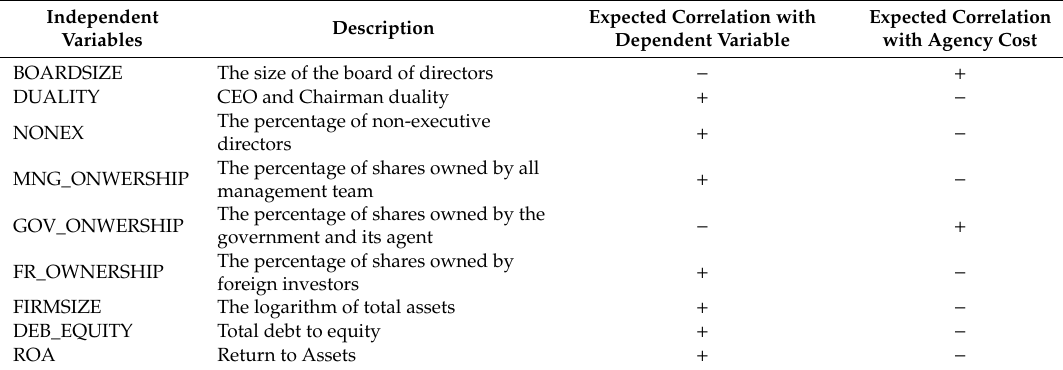
Table 1. Hypotheses summary.